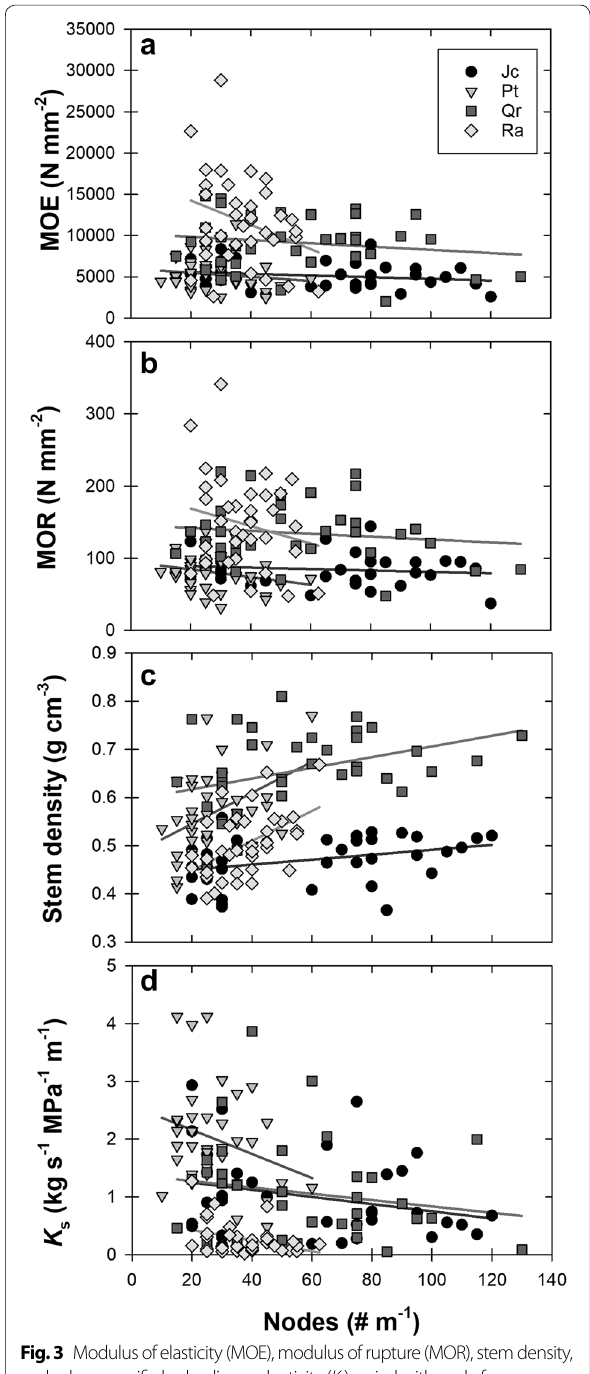
Fig. 3 Modulus of elasticity (MOE), modulus of rupture (MOR), stem density, and xylem-specific hydraulic conductivity ( K s ) varied with node frequency. Each point represents a stem sample. Node frequency was associated with MOE ( F 1,143 7.00 P 0.009), MOR ( F 1,143 4.63 P 0.033), stem density = = = = 27.38 P < 0.001), and K s ( F 1,143 6.54 P 0.012). For MOE, MOE, and ( F 1,143 = = = K s , there were no interactions between species ( P > 0.05 for node*species term), but for stem density, there was a significant interaction between species ( F 3,143 3.74 P 0.013). Lines are included to assist with the visual = = interpretation of patterns in the data. Species are indicated with different symbols within each panel and species abbreviations are included in Table